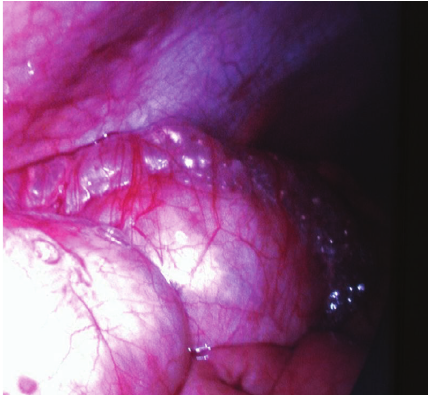
Figure 2: Figure shows a closure view of cystic appearance of the pneumatosis intestinalis on ascending colon with anterior abdominal wall